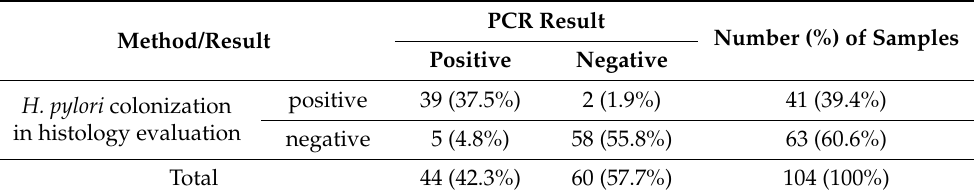
Table 1. Comparison of the results obtained with application of PCR with respect to their histological investigation results ( n = 104).